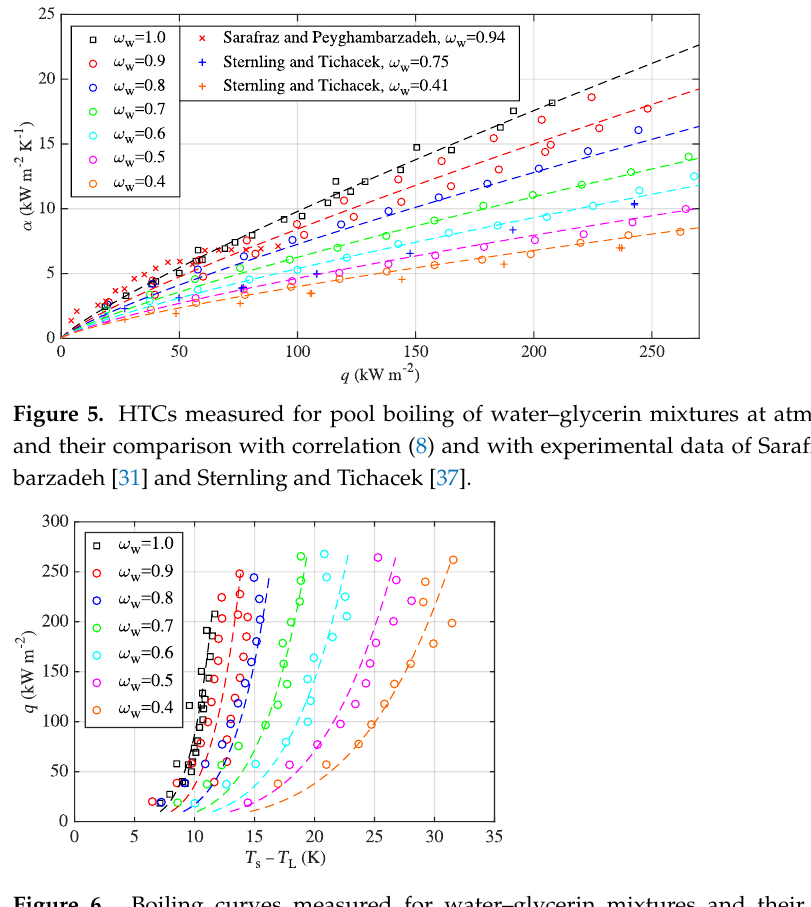
Figure 6. Boiling curves measured for water–glycerin mixtures and their comparison with correlation